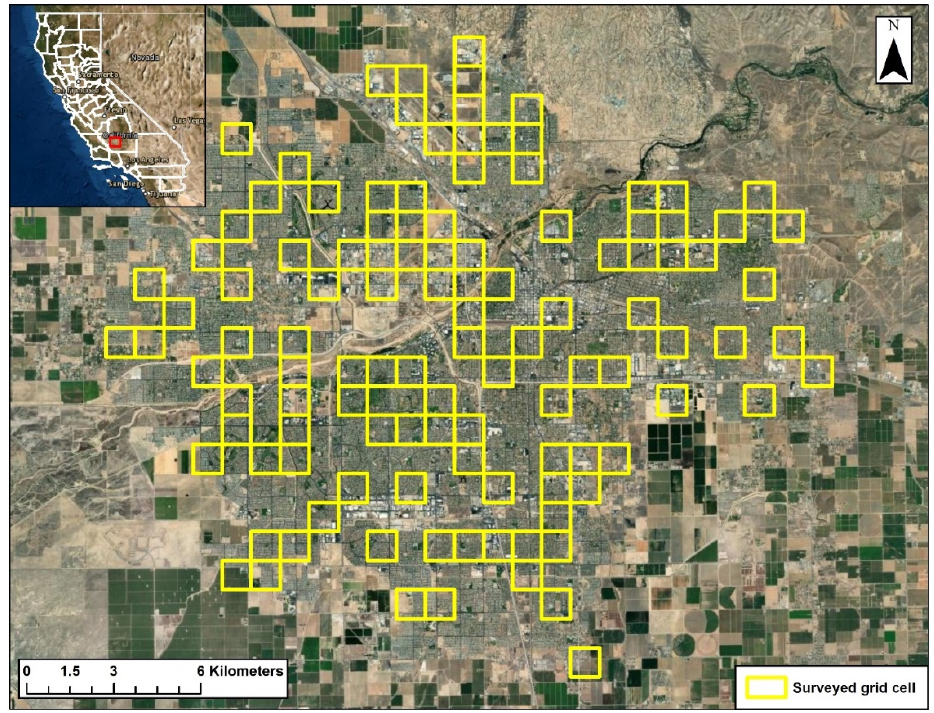
Figure 1. City of Bakersfield, California, with 1 km 2 grid cells that were surveyed for the presence of San Joaquin kit foxes and red foxes from 2015 to 2021.